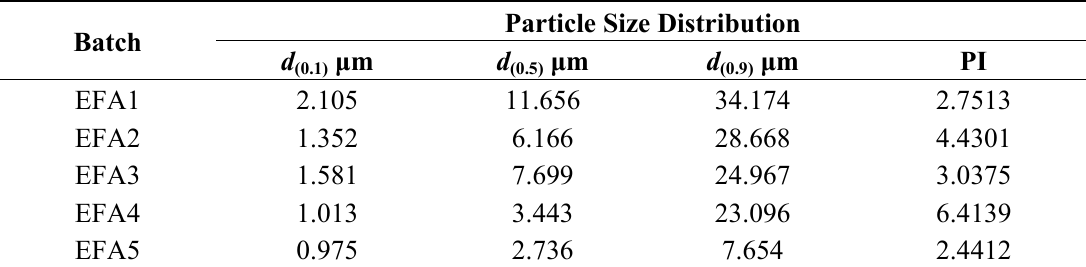
Table 2. Particle size distribution of efavirenz batches